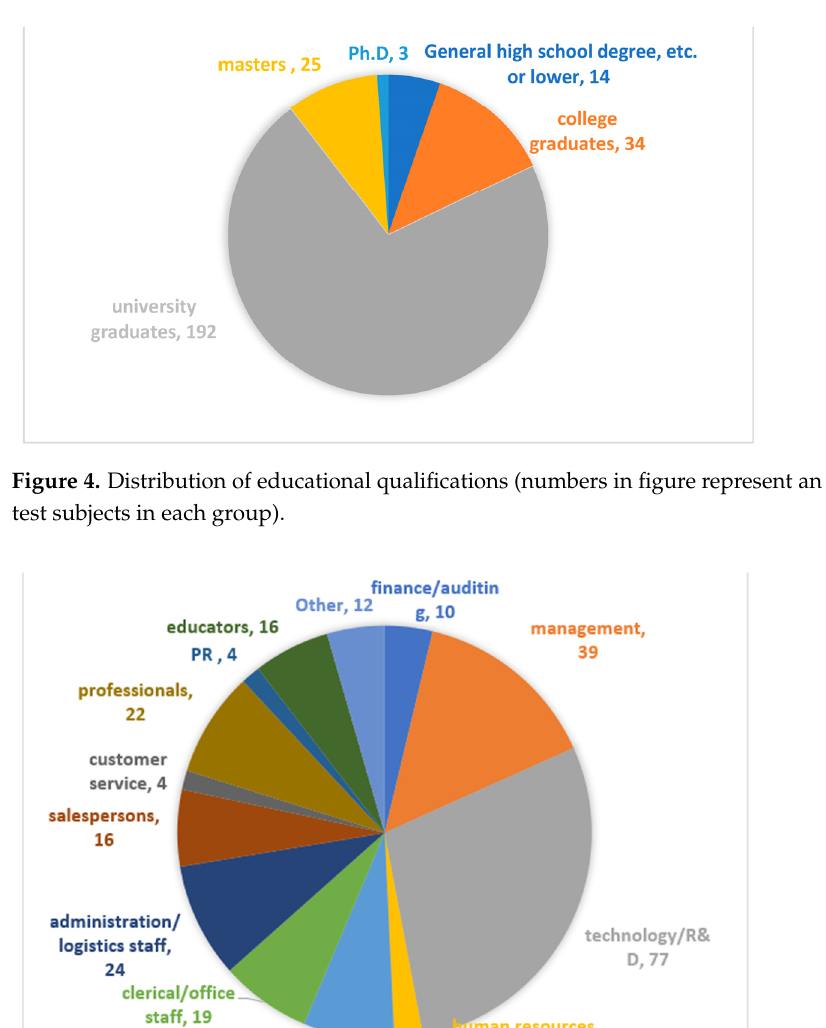
Figure 3. Distribution of age (numbers in figure represent an actual number of test subjects in each group).